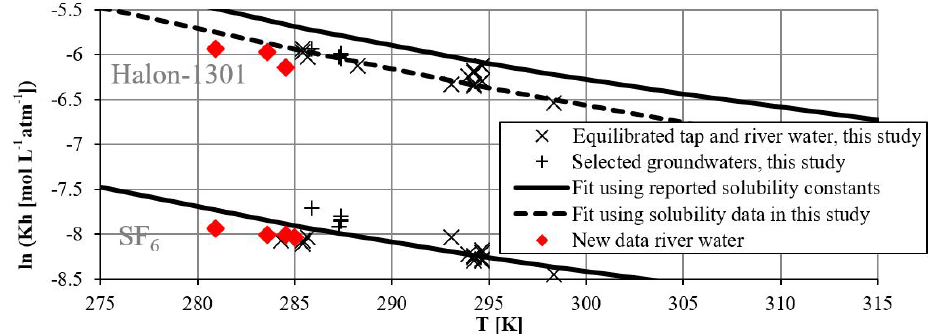
Figure 5. Estimated solubility of Halon-1301 and SF 6 in equilibrated tap water, river water and oxic young groundwater in comparison modelled solubility based on reported solubility data using 3 data from Deeds (2008) for Halon-1301 and Bullister et al. (2011) for SF 6 .